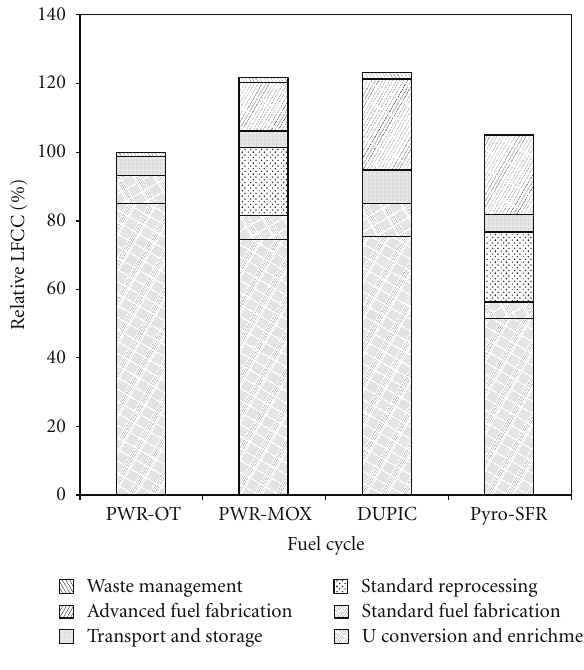
Figure 3: Relative LFCC of four fuel cycles.